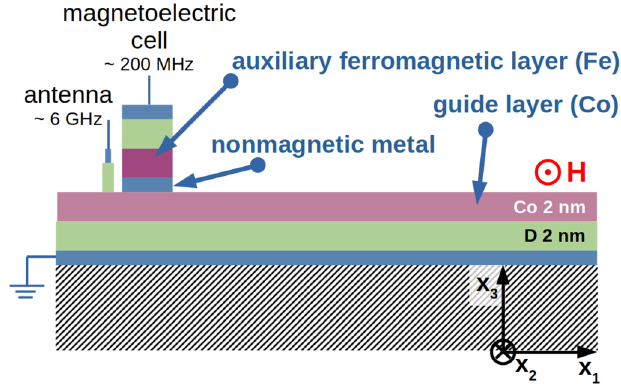
Figure 4. The spin-wave waveguide from Co thin film with the magnetoelectric cell for amplification and amplitude modulation of the spin